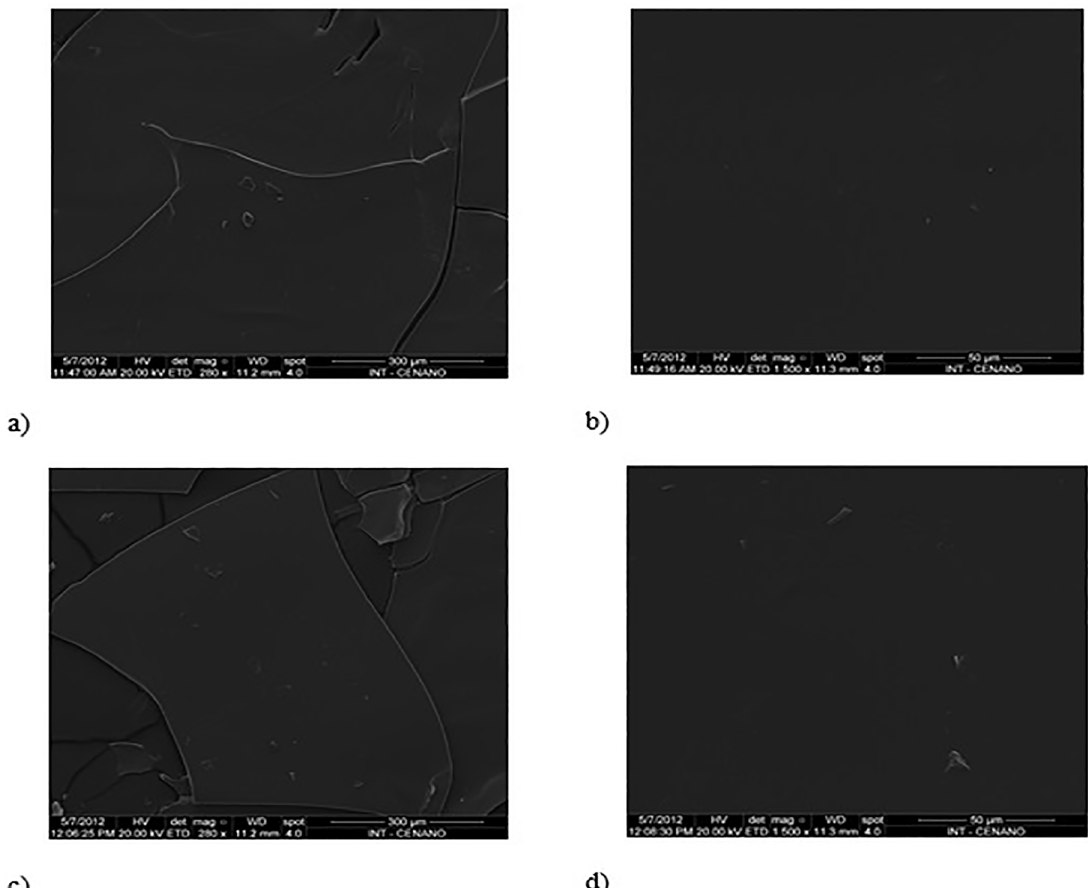
O in 95% Al O : a) microanalysis of A1 and A2 with x y 2 3